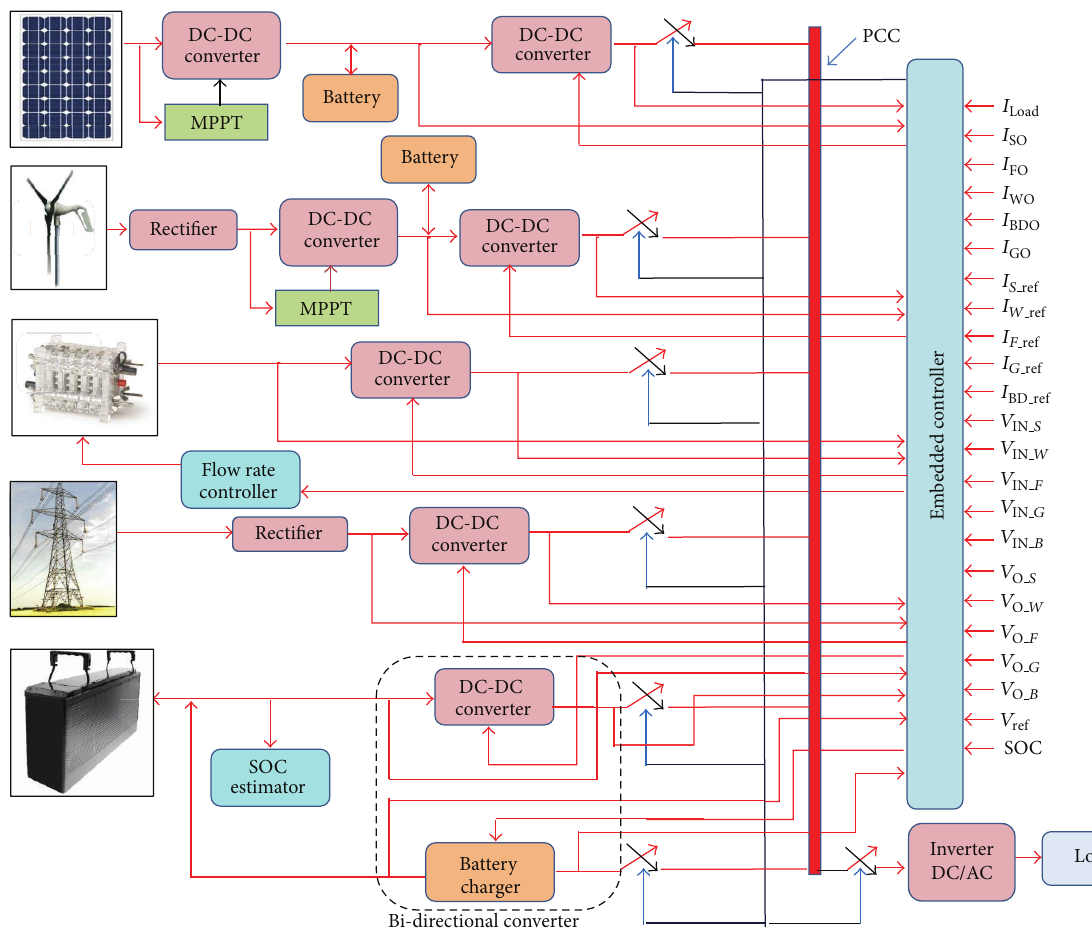
Figure 1: Solar PV/WTG/fuel cell/grid fed hybrid power